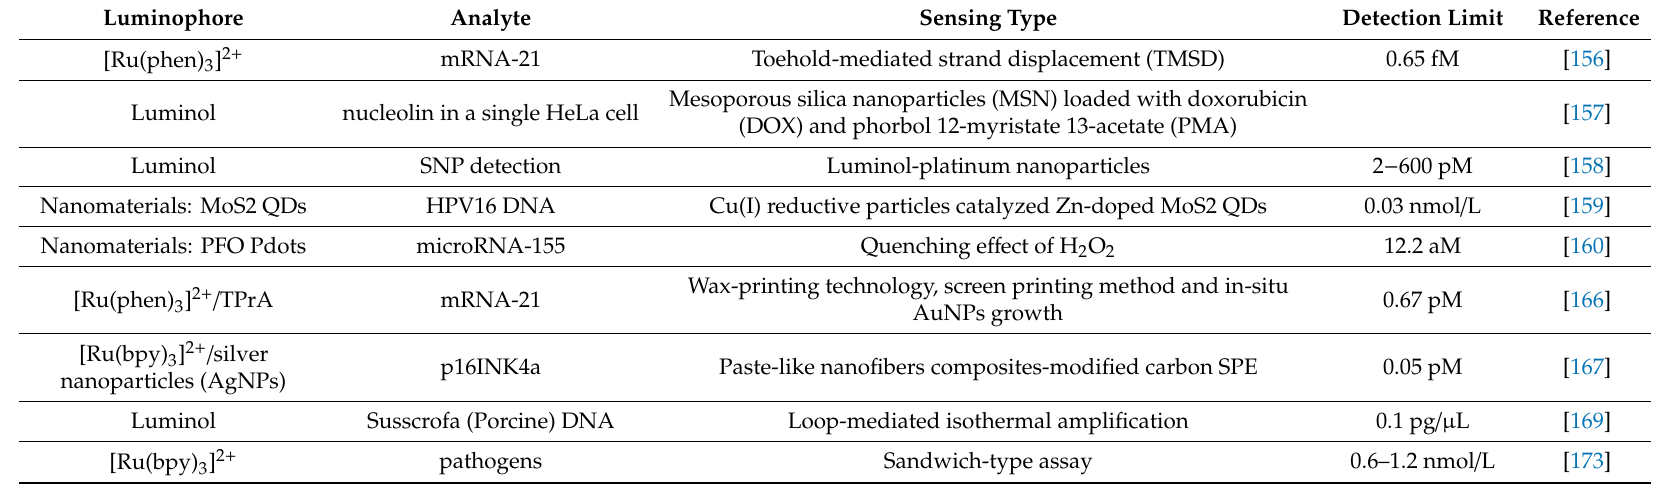
Table 3. Analytical parameters of SPE-based ECL DNA